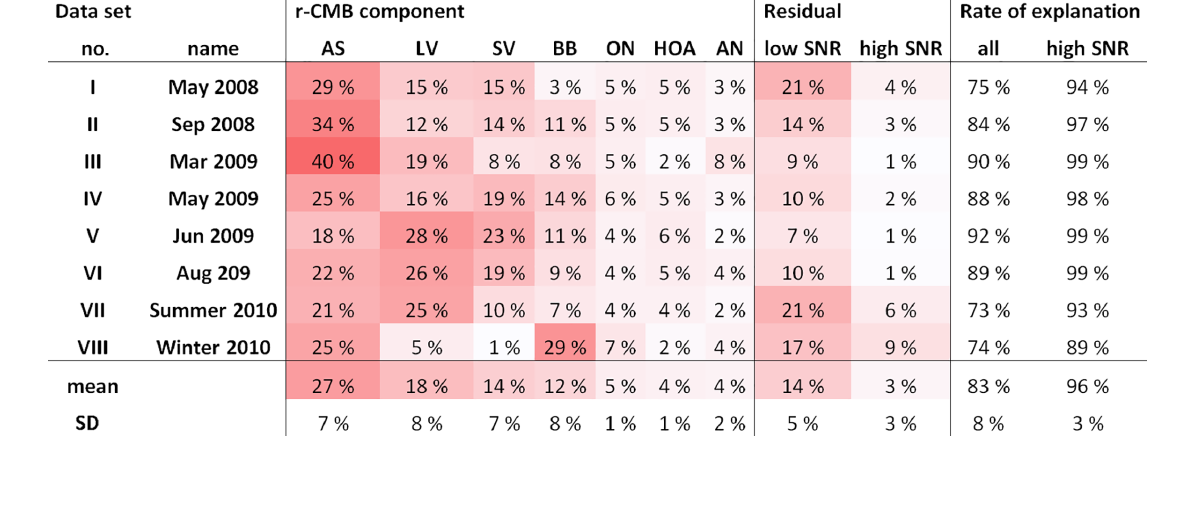
Table 3. Explained variations (EV, in percent) for the r-CMB model.